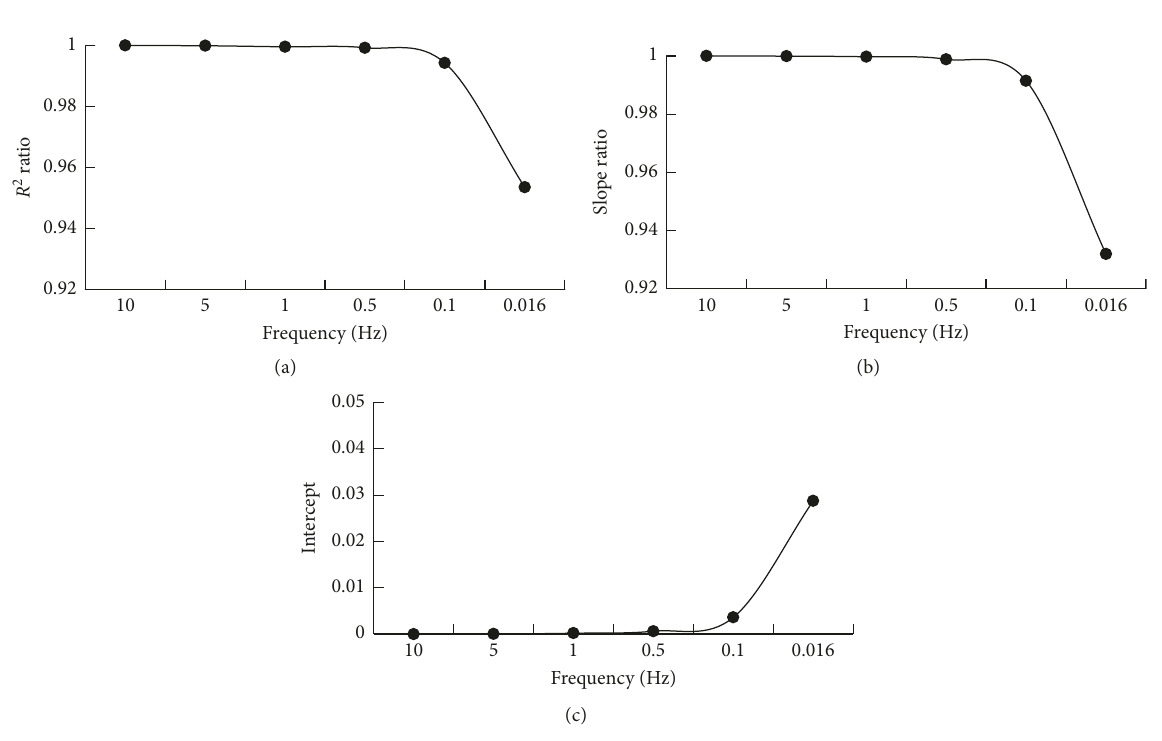
H FV and EC , of data analysis at each